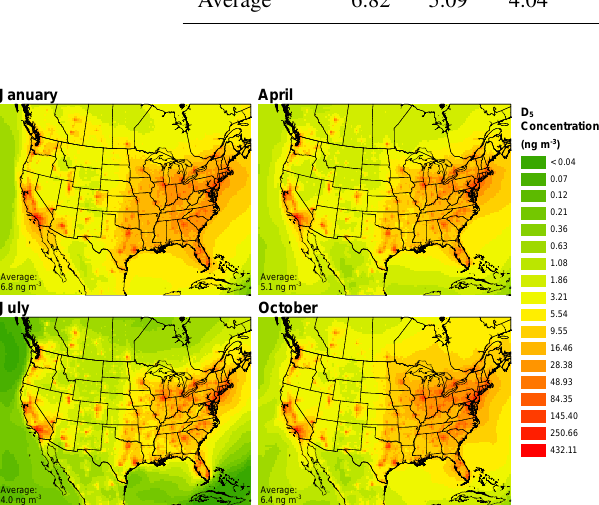
Figure 1. Monthly averaged surface layer D 5 concentrations. The domain average concentration is shown in the lower left for each month.